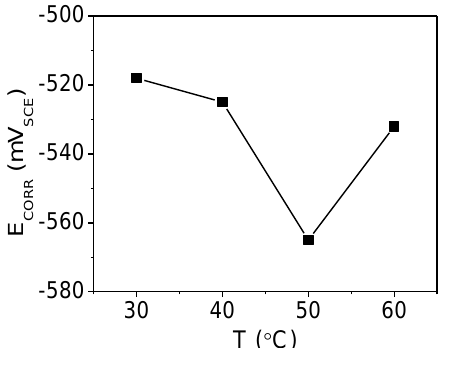
Figure 2. E values for mild steel in a HCl solution with 0.5 mM of PMBH at various CORR solution temperatures.